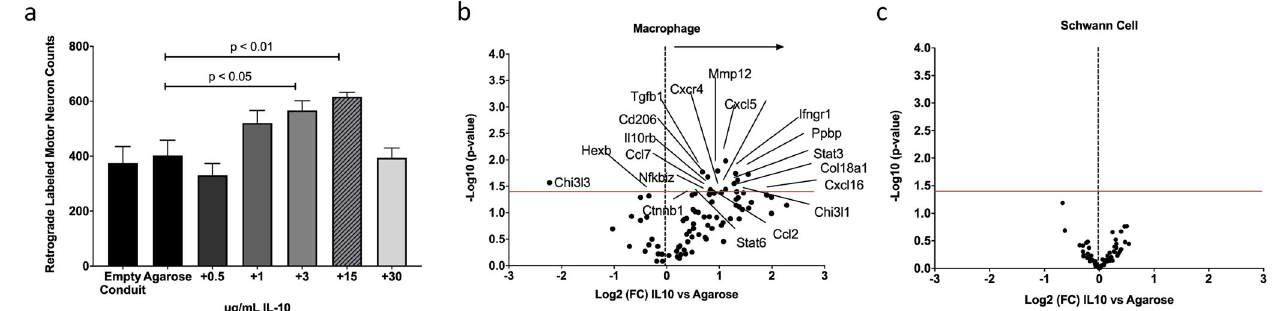
Fig. 6 Transient immunomodulation produces a dose-dependent improvement in motor neuron regeneration. a Dose-dependent effect of exogenous IL10 in mice 8 weeks after repair. Number of retrograde-labeled regenerating MN were signi fi cantly elevated in the 3 µg/mL and 15 µg/mL IL10 groups ( P < 0.05, P < 0.01, Dunnets vs agarose only control). b IL10 modulates local macrophage ( b ) but not Schwann cell ( c ) response. Gene expression (nanoString) of macrophages and Schwann cells isolated from the repair site by FACS 3 days after sciatic nerve repair in the presence (15 µg/mL) and absence (agarose only) of IL10. Signi fi cantly different gene expression above the horizontal red line representing false discovery rate ( P <0.05, nSolver, Naonstring). c No differences were observed in SC gene expression at the same time point.